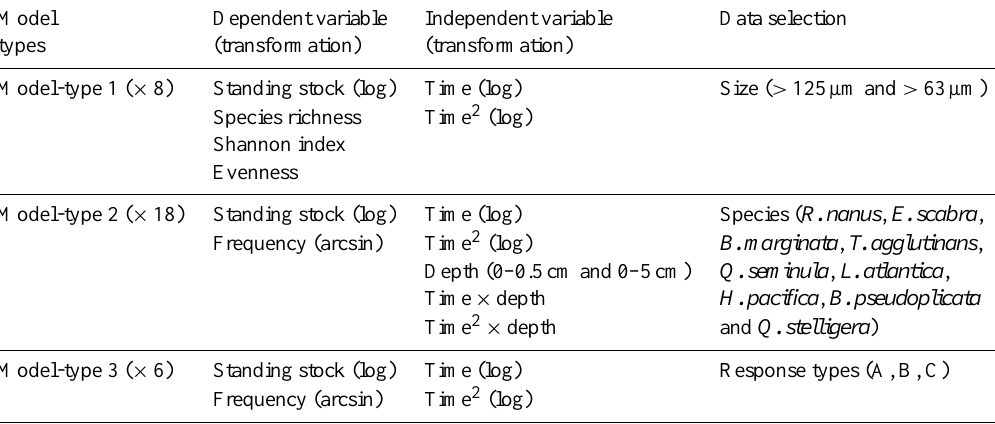
Table 2. Name and number of the linear models. For each model type the different dependent and independent variables are listed and the transformation used is presented in brackets. As the models are executed on different data, the categories of the selection are